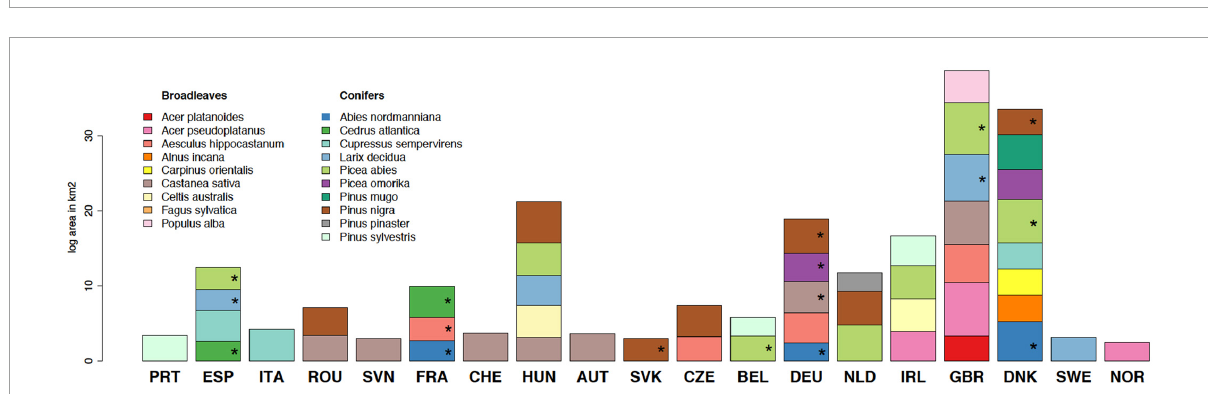
FIGURE4 Difference in species status, native, and non-native in Europe. The log area of species native to some regions in Europe but introduced outside their natural range in other European countries. Tree species occurrence data are taken from EUFORGEN and EU-Forest databases. The area is calculated as the number of 1 km 2 grid cells, where the species occurrences have been reported. Stars indicate species in given countries that were also reported in the